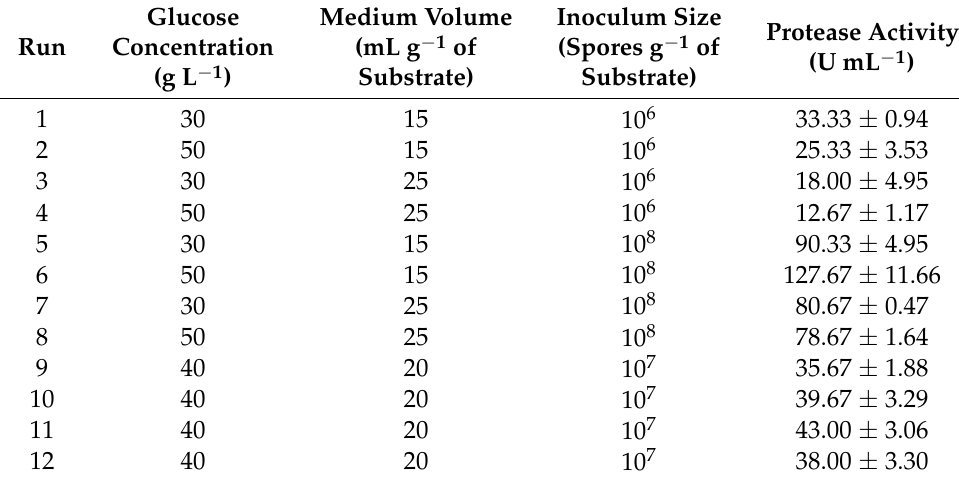
Table 1. Experimental conditions and results of protease production by Aspergillus tamarii URM4634 in sequential fermentations using wheat bran as a substrate. Runs were carried out according to a 2 3 -full factorial design plus three central points.